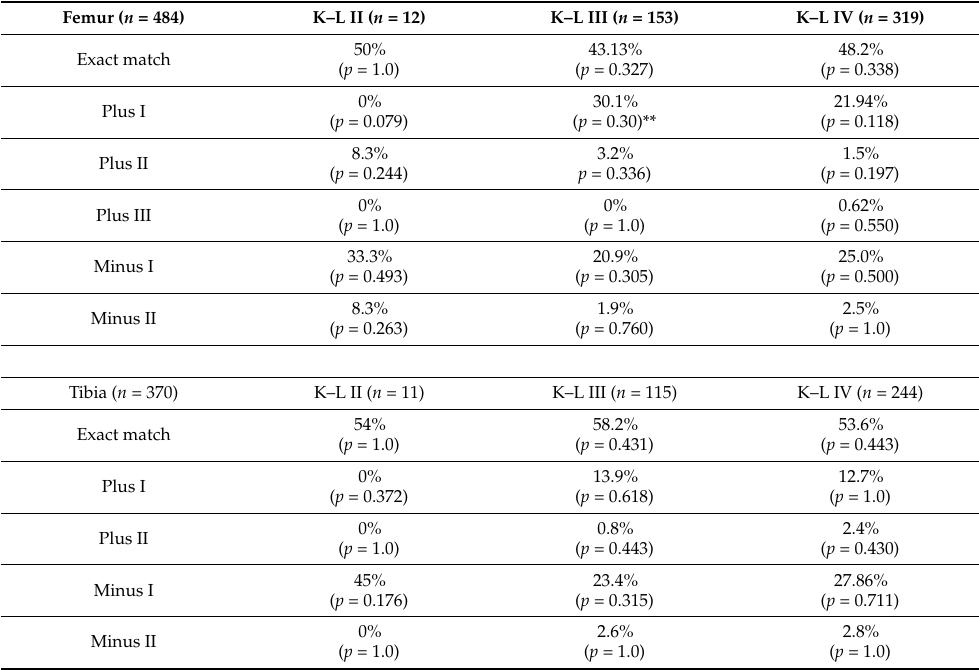
Table 5. Kellgren–Lawrence score and adherence to planning; p -values from each Fischer’s exact test. Each experience group and match were tested against all other groups and matches. ** = significantly more often implanted than all other experience groups; K–L = Kellgren–Lawrence